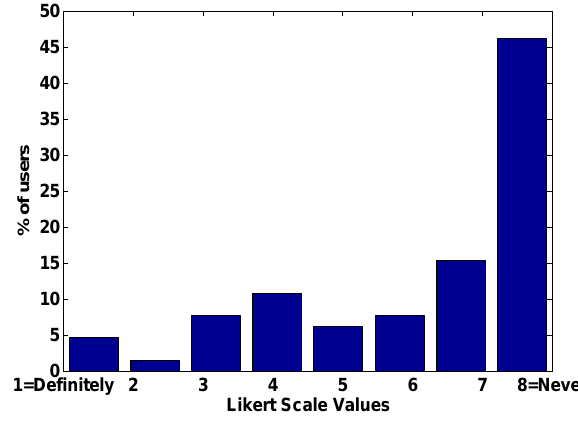
Figure 1. App Installation and EULA